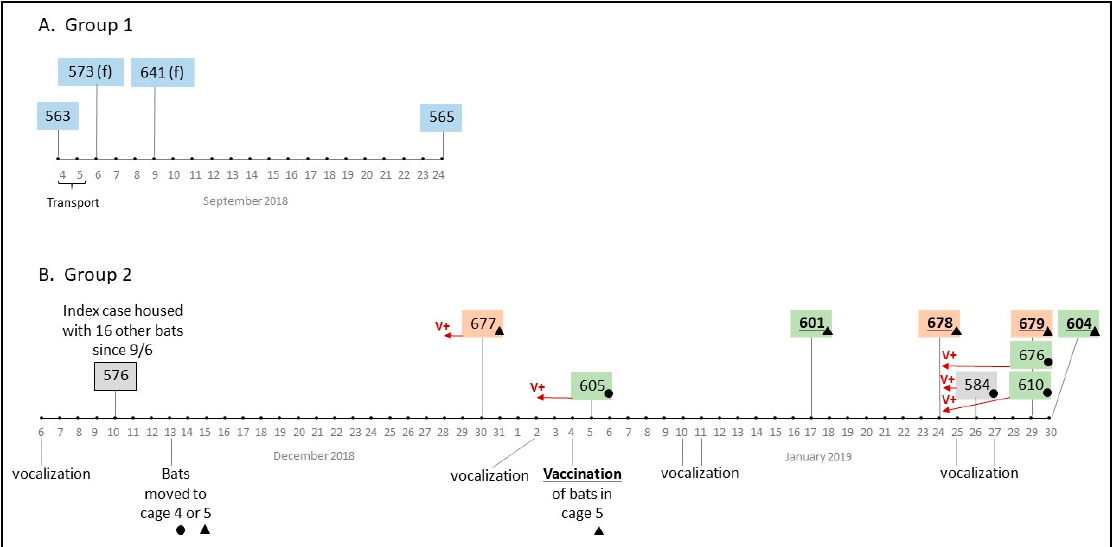
Figure 2. Timeline of vampire bat observations and mortalities recorded in Madison, Wisconsin, from September 2018 to January 2019. All bats were captured in México in August and transported to Madison on September 4–6. Bats from Groups 1 ( A ) and 2 ( B ) were never in contact since capture and presented two distinct RABV lineages based on phylogenetic analysis of N and G gene sequences. Bats in Group 1 with “(f)” are females and were never in contact with males from the same site. Sites of capture are color coded: Loma (blue), Catedral (gray), Guadalcázar (green), and Milagro (orange). Group 2 bats moved to Cage 4 after the first rabies mortality in that group (#576) are indicated with a circle and those moved to Cage 5 with a triangle. Bold/underline lettering indicates bats that were vaccinated. “V+” indicates RABV shedding detected in oral swabs prior to mortality.